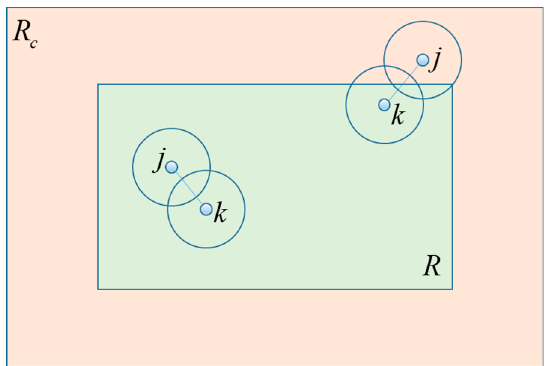
Figure B1. The fictitious domain, 𝑅 (cid:3030) , outside of the actual solution domain, 𝑅 . Figure A2. The fictitious domain, R c , outside of the actual solution domain, R . Clamped Boundary Condition